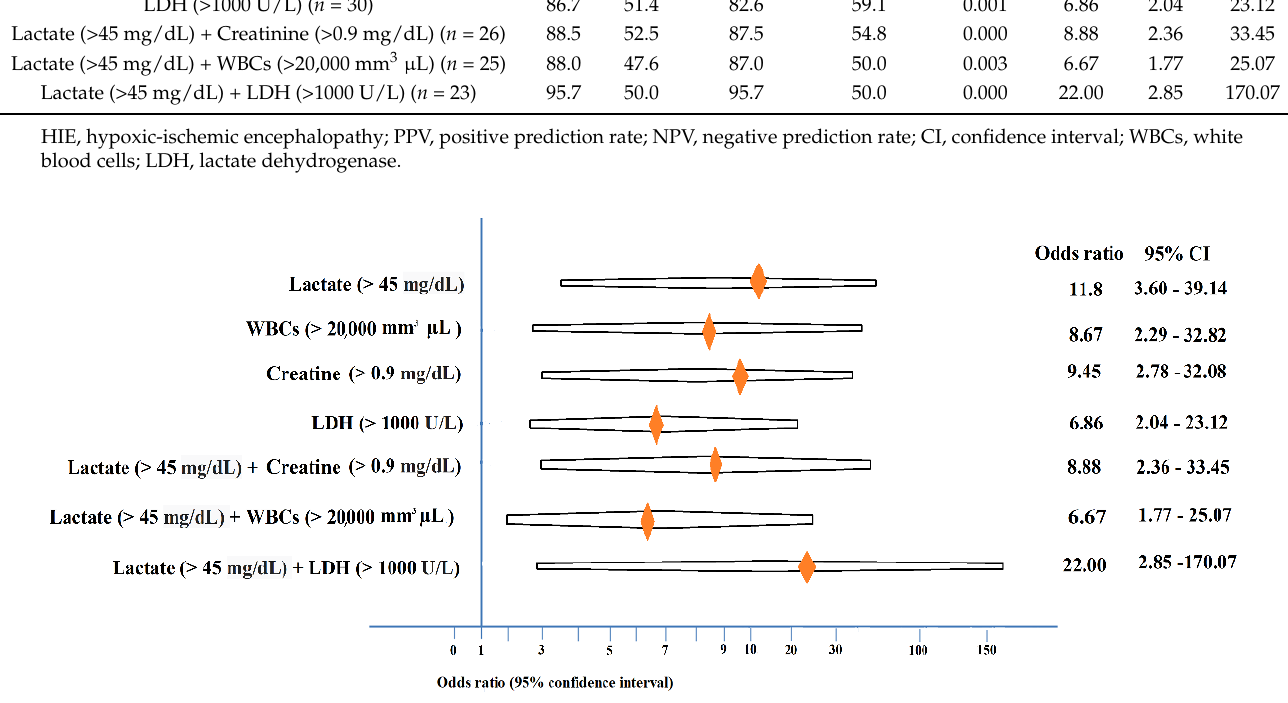
Table 5. Application of single and combined biomarkers to determine the odds ratio, PPV, NPV, sensitivity, and specificity. Blood Biomarkers